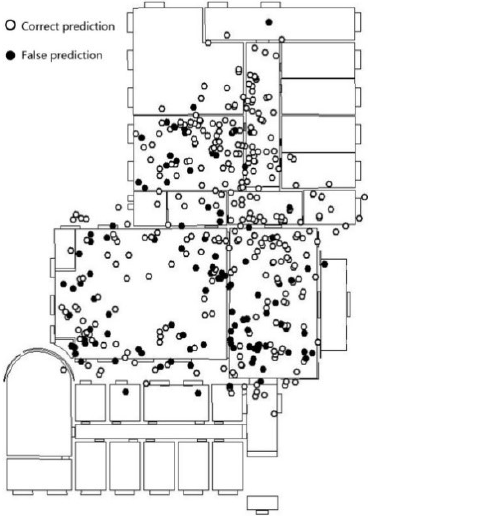
Figure 9. Overlapping result of location points in the 2nd floor of the laboratory.